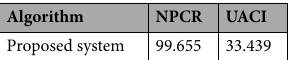
Table 5. The results of NPCR and UACI matrices.